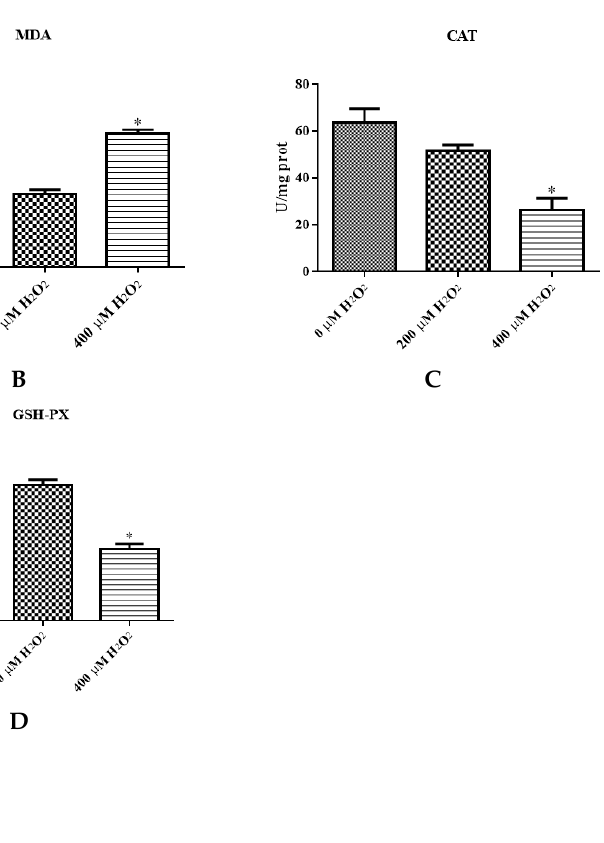
Figure 3. The IDECs were treated with various concentrations and incubation times of H 2 O 2 (0–500 μM, 2 h and 6 h) and the cell viability was estimated by CCK-8 assay. The data were presented as percent viability of IDECs when treated with different conditions of H 2 O 2 . The data were analyzed through one-way ANOVA and are expressed as the mean ± SE ( n = 3). * p < 0.05 compared to 0 μM H 2 O 2 .